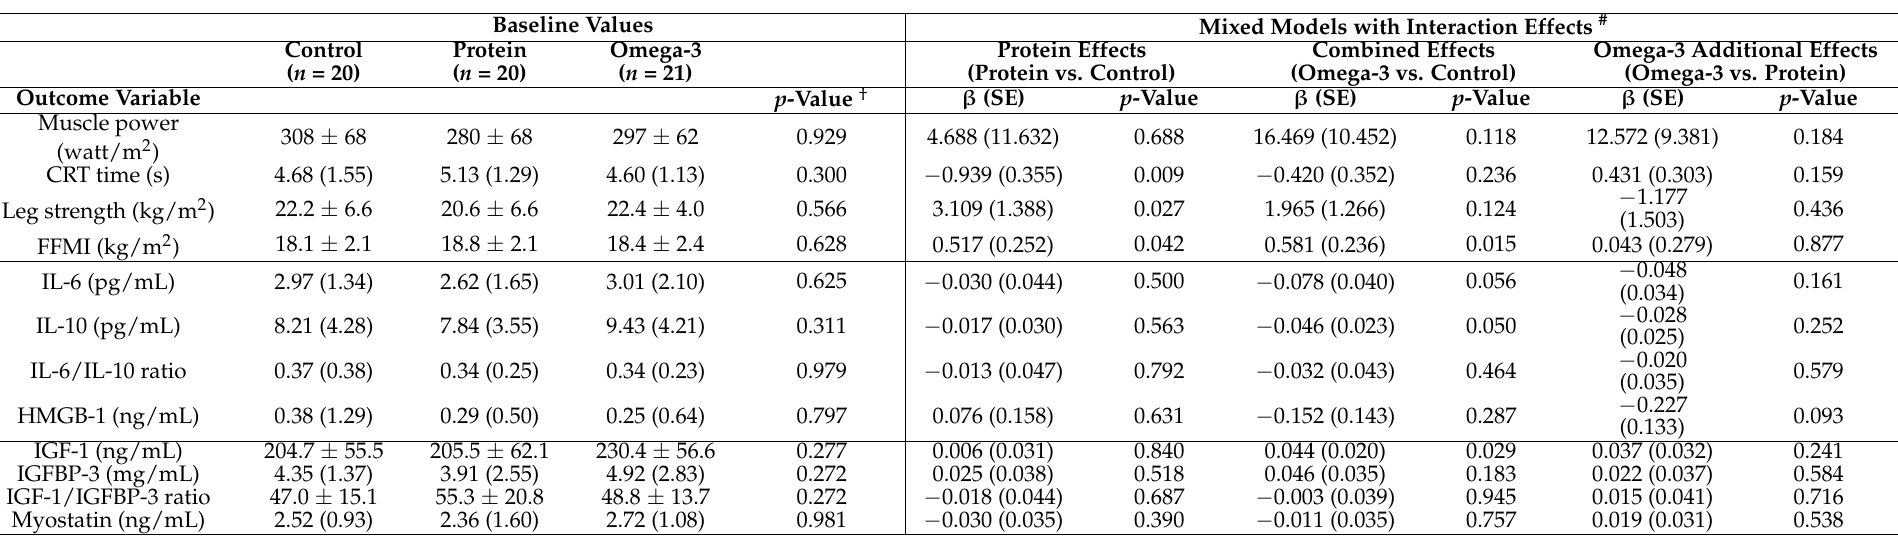
Table 2. Baseline values and effects of eight weeks of high-protein (protein) or high-protein plus omega-3 (omega-3) diet in comparison to control on muscle parameters, body composition and